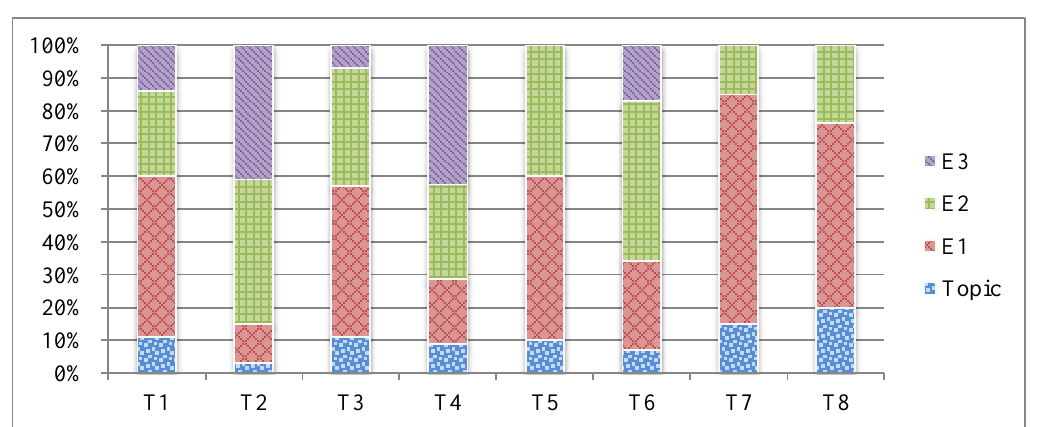
Proportion of Topics and Levels of Elaboration for Texts